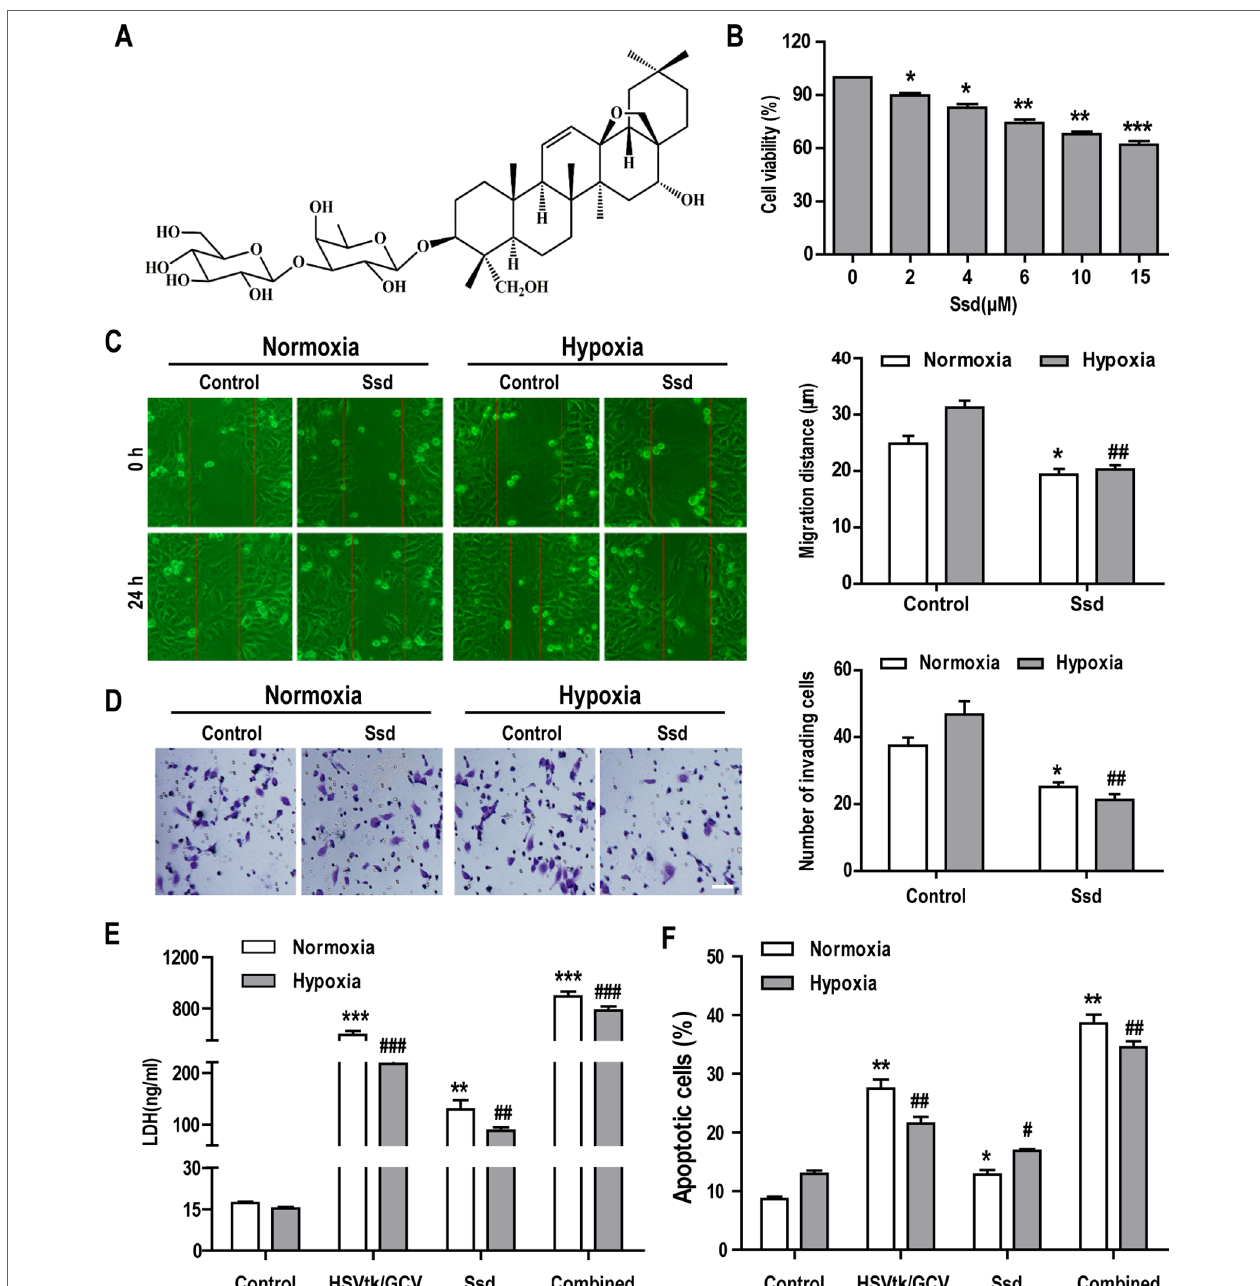
FIGURE 3 | Saikosaponin-d (Ssd) markedly inhibits the malignant phenotype in Hep3B cells and increases their sensitivity to chemotherapy under hypoxic conditions. (A) Chemical structure of Ssd. (B) The viability of Hep3B cells treated with different concentrations of Ssd for 48 h was examined using the CCK-8 assay. (C) The effects of Ssd (6 µM) on the migration of Hep3B cells under normoxic and hypoxic conditions were examined over 24 h by wound healing assay (scale bar, 50 µm). (D) The effects of Ssd on the invasive potential of Hep3B cells were examined by transwell assay under normoxic and hypoxic conditions (scale bar, 50 µm). (E) Lactate dehydrogenase (LDH) expression in Hep3B cells was measured by enzyme-linked immunosorbent assay (ELISA) following exposure of cells to the indicated treatments. (F) Hep3B cell apoptosis was examined by flow cytometry. Data are shown as means ± SD (n = 3); *P < 0.05, *P < 0.01, and *P < 0.001 when compared with the normoxia control; # P < 0.05, ## P < 0.01, and ### P < 0.001 when compared with the hypoxia control (Student’s t